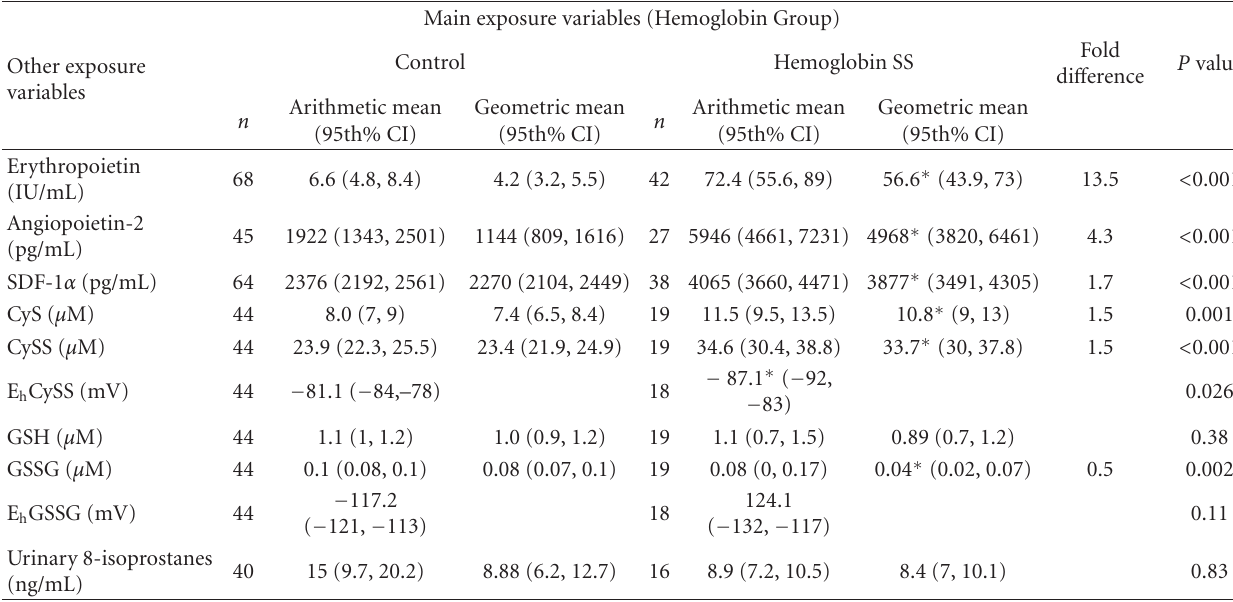
Table 3: Angiogenic growth factors and oxidant stress markers for each Hemoglobin Group. Children with Hemoglobin SS had higher levels of three angiogenic growth factors, higher cysteine and cystine, and lower oxidized glutathione than Controls. Significant di ff erences in the geometric means between Control and Hemoglobin SS groups are indicated by asterisks ( ∗ ).